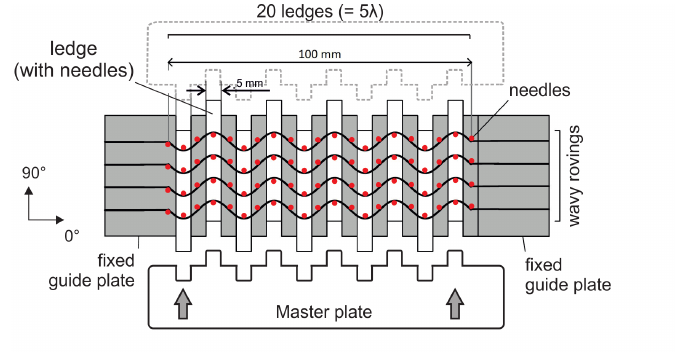
Figure 1. Sliding mechanism with ledges (needles in red) to induce sinusoidal waves into fabrics.